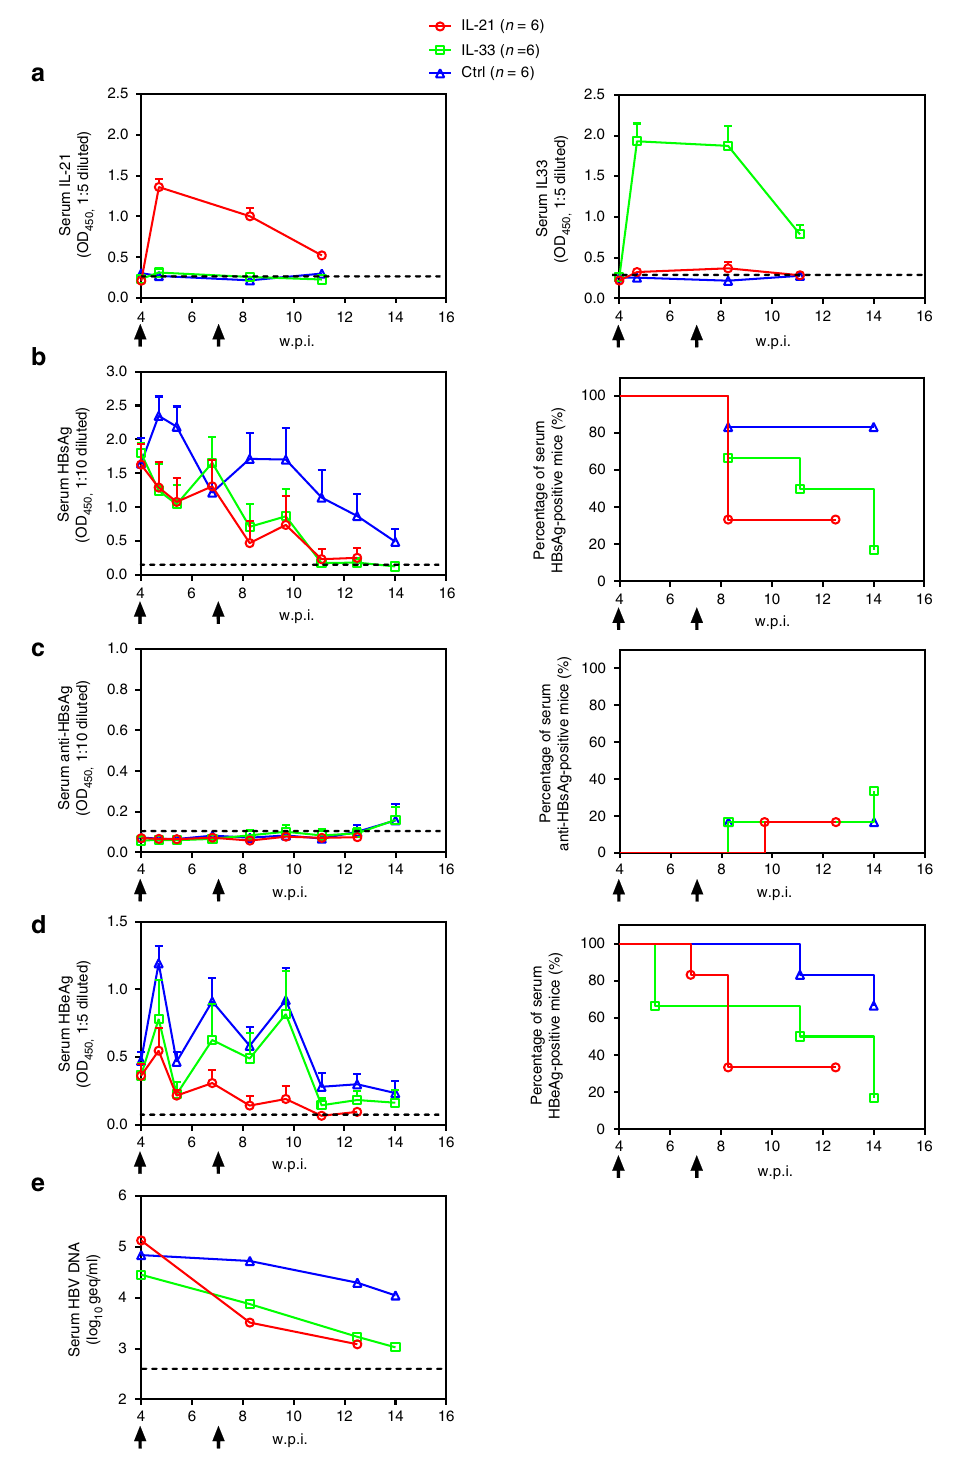
Fig. 6 IL-21 or IL-33 treatments induce clearance of established BPS persistence. Plasmids expressing murine IL-21 or IL-33 and empty vector control were injected into BPS HDI mice at 4 and 7 weeks post injection (w.p.i.) (arrows). Sera were collected at indicated time points and levels of IL-21 and IL-33 ( a ), HBsAg ( b ), HBsAb ( c ) and HBeAg ( d ) were analysed using ELISA. Group means and s.e.m. within group are presented with group sizes ( n ) indicated. Group positivity percentage data are also presented for HBsAg ( b , right panel), HBsAb ( c , right panel) and HBeAg ( d , right panel). HBV DNA for each group were analysed using pooled serum in commercial quantitative assay ( e ). Dotted lines represent cut-off thresholds ( a , b – d , right panels) and lower limit of quanti fi cation ( e ) respectively. geq genome